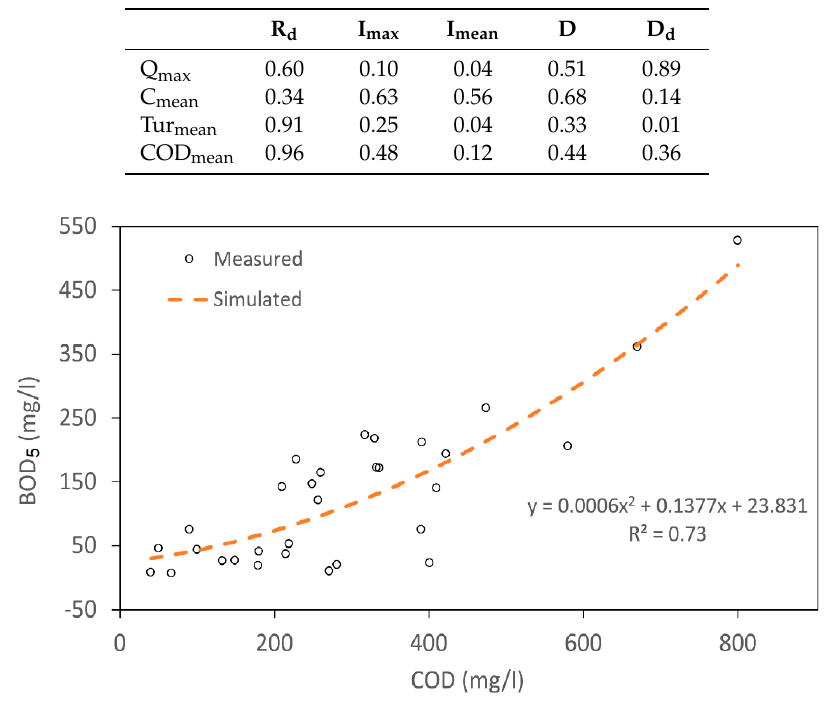
Table A4. Statistical significance ( p values) of the correlations between the variables of rainfall and CSO in the Multifamiliares CSO.